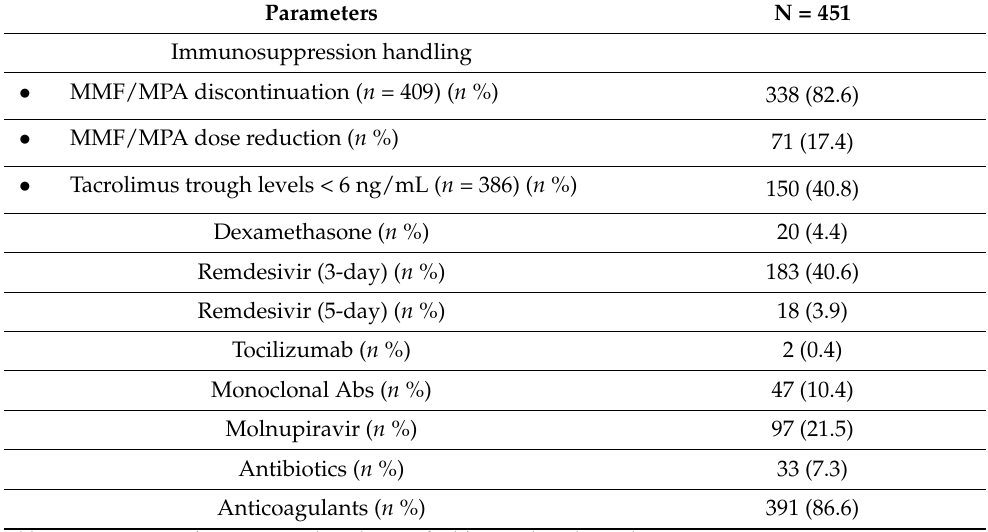
Table 6. Therapeutic management of COVID-19 during the Omicron